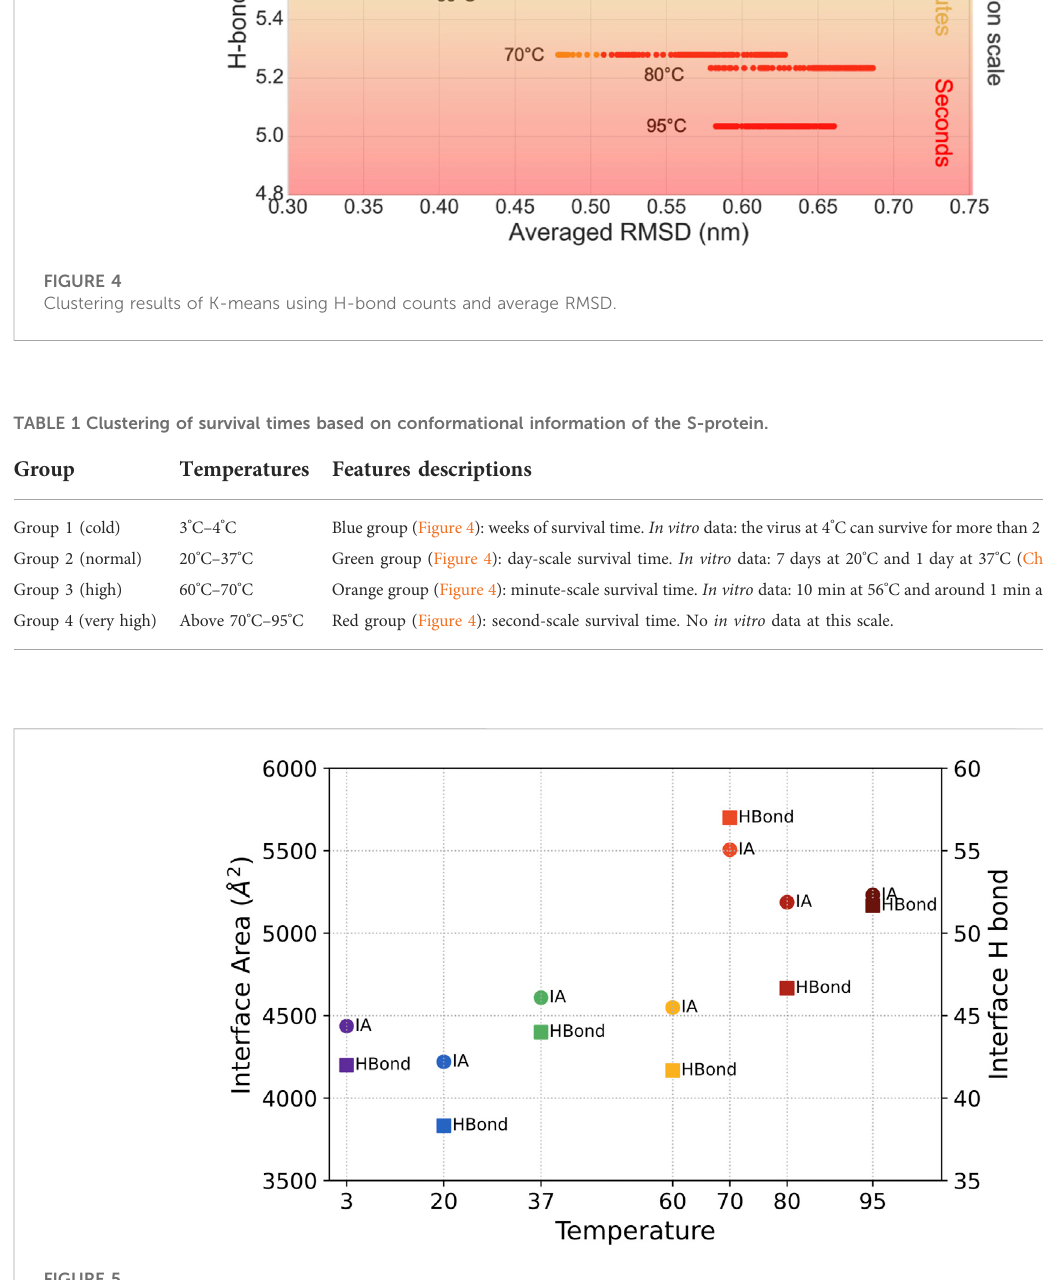
FIGURE 5 The averaged interface area (marked as IA) and the number of H-bond across the interface (marked as Hbond) between three chains for S-protein from 3 ° C to 95 °